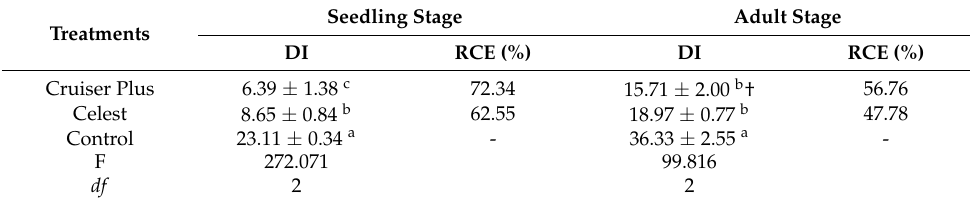
Table 3. Relative control efficacy of wheat FCR by two chemical agents, Cruiser Plus and Celest.